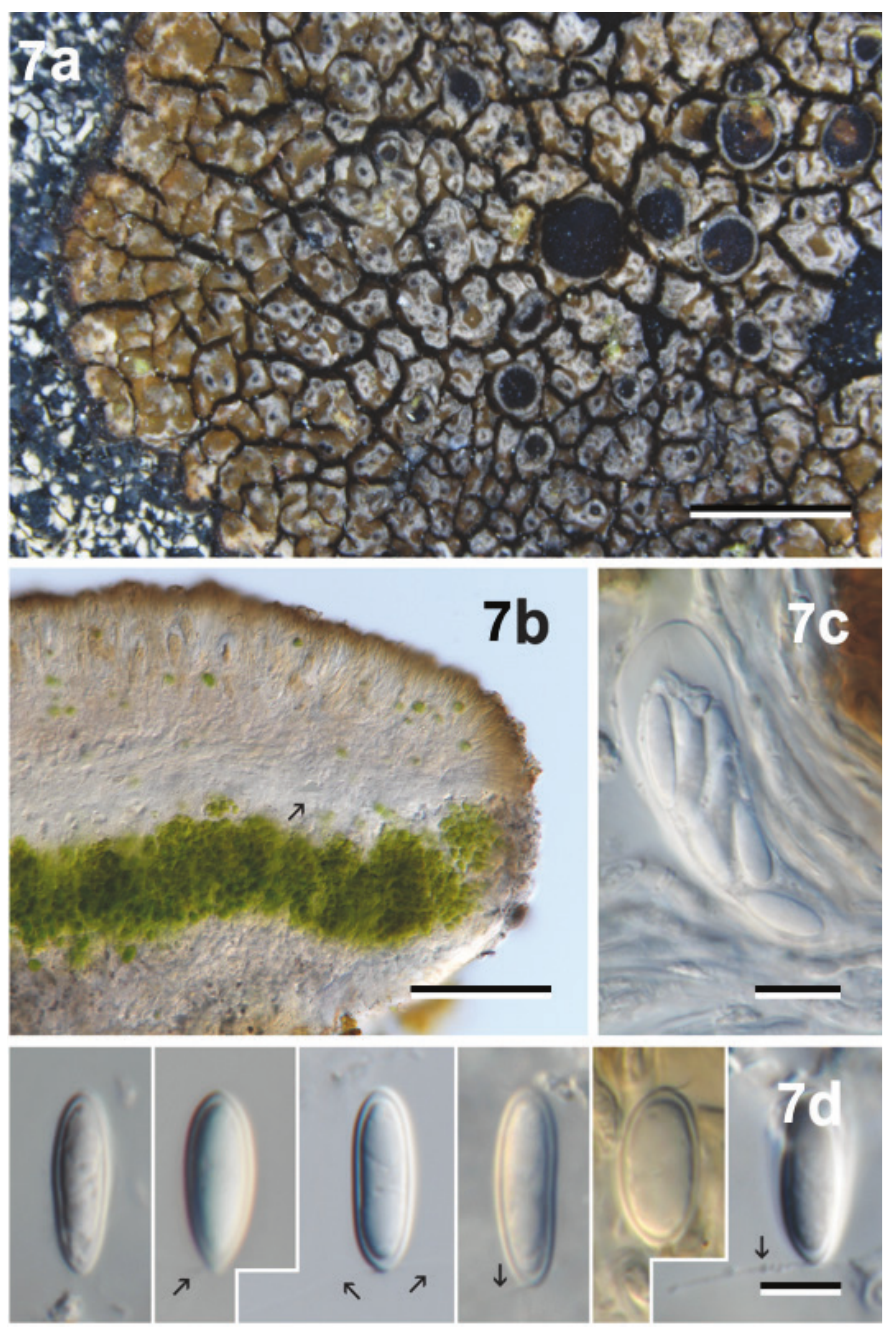
Figure 7. Neoprotoparmelia capensis , holotype Crespo, Divakar, Hawksworth, Amo & Lumbsch 63f (MAF-Lich. 19584). a Habit b Section through centre of apothecium, showing cupular proper exciple (arrow) c Ascus d Spores, showing setae (arrow). Scale bars: 2 mm ( a ), 100 μm ( b ), 10 μm ( c ), 5 μm ( d